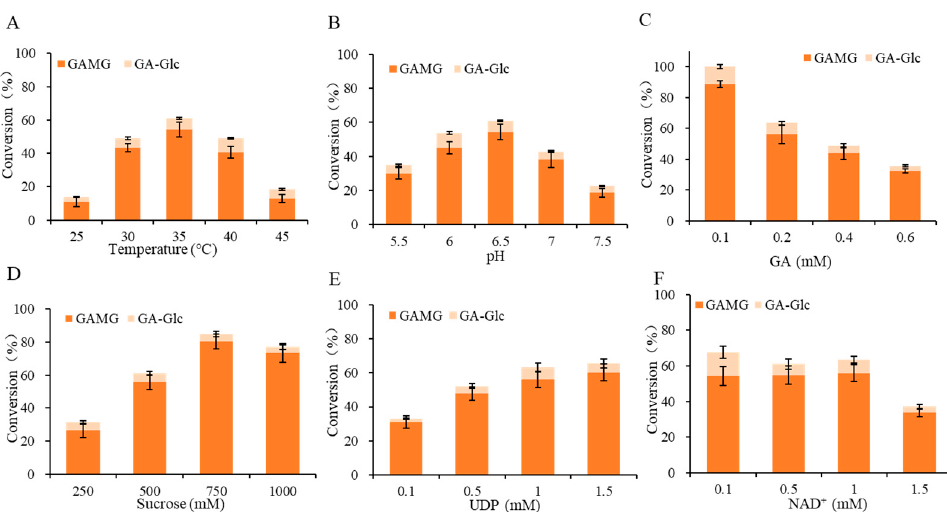
Figure 6. Effects of key parameters on the glycosylation of GA enzyme module system. Effects of temperature ( A ) and pH ( B ) on the cascade reaction. Effects of the concentration of GA ( C ), sucrose ( D ), UDP ( E ), and NAD + ( F ) on the cascade reaction. Error bars represent the standard deviation from three repeats.